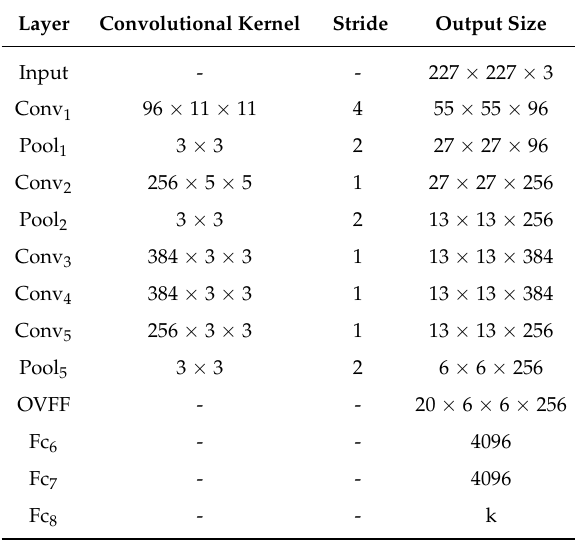
Table 1. The input and output sizes of each layer of our MVCNN for pose classification, where the number of views is 20 and k is the number of pose